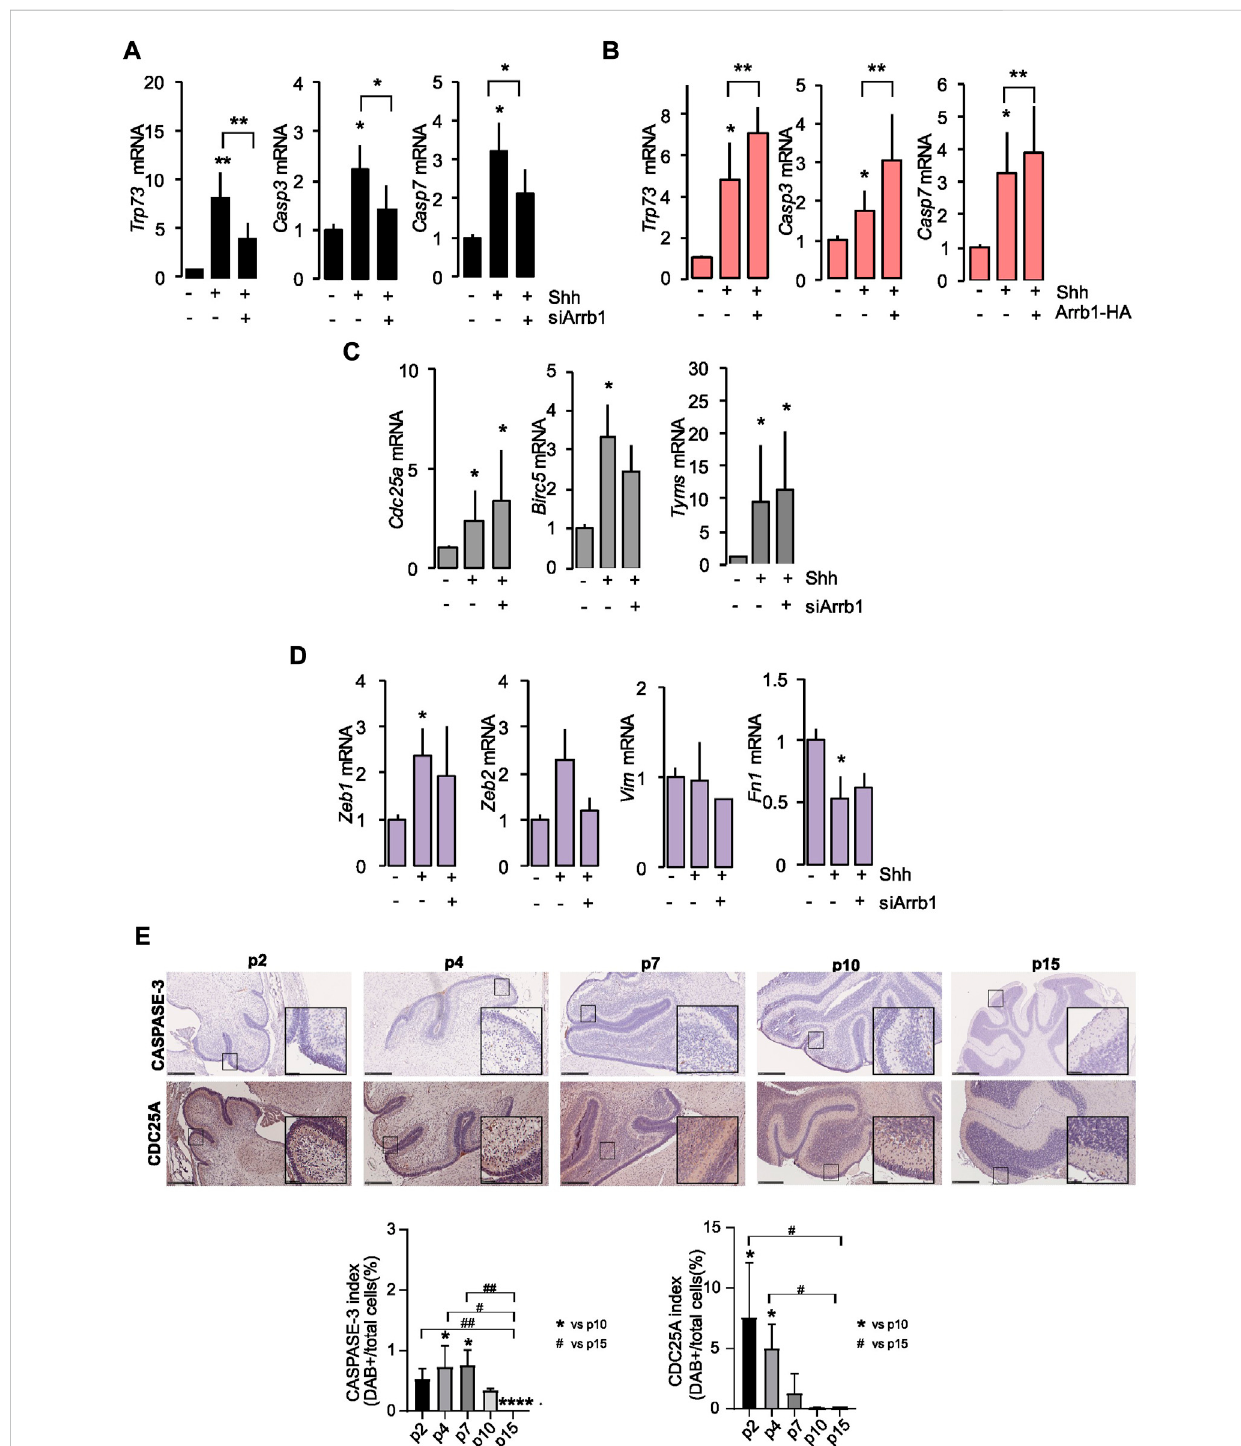
FIGURE 2 E2F1-ac targets ’ transcripts after ARRB1 modulation. (A,B) Expression of pro-apoptotic E2F1-ac target genes ( Trp73, Casp3 and Casp7 ) in GCPs that had or had not undergone siArrb1 (black) or over-expression of Arrb1 (Arrb1-HA) (orange). (C,D) Expression of proliferative (grey) and epithelial mesenchymaltransition(violet)E2f1-actargetgenes( Cdc25a,Birc5,Tyms,Zeb1,Zeb2,Vim and Fn1 )inGCPsthathadorhadnotundergonesiArrb1.Data represent means ± S.D., from at least three independent experiments; * p < 0.05; ** p < 0.01; *** p < 0.001. (E) IHC staining for ARRB1 and P27 in representative mouse cerebellum sections at several differentiation stages (p2, p4, p7, p10, p15) (upper panels). Magni fi cation ×10; insets ×40. Scale bar, 250 µm. CASPASE-3 and CDC25A indexes (expressed as percentage) calculated as DAB positive cells of total number of cells (bottom panels). Data represent means ± S.D., from at least three independent experiments; * p < 0.05; ** p < 0.01; *** p < 0.001; **** p < 0.001 vs. p10. # p < 0.05; ## p < 0.01 vs.